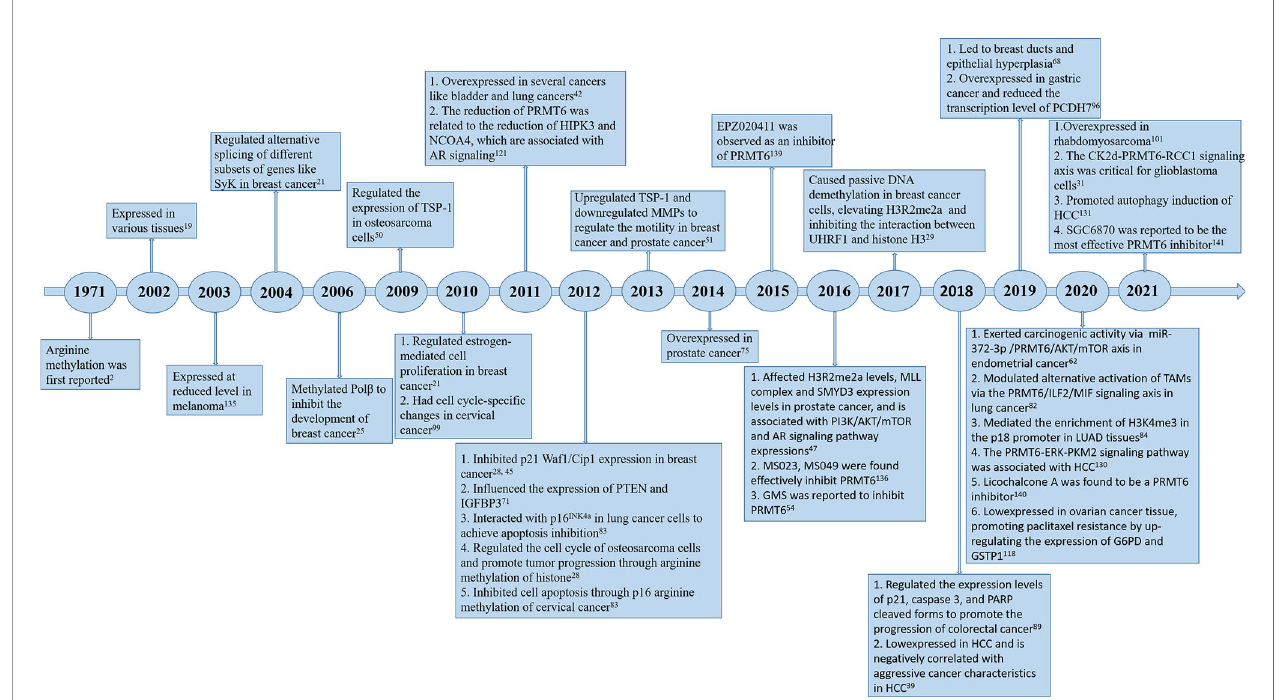
FIGURE 1 | Timeline of PRMT6 research. A brief history of functional and pharmacological studies of